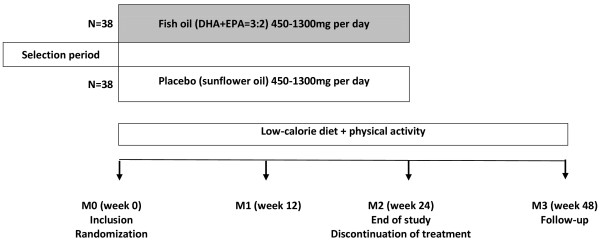
Schematic of the trial design.